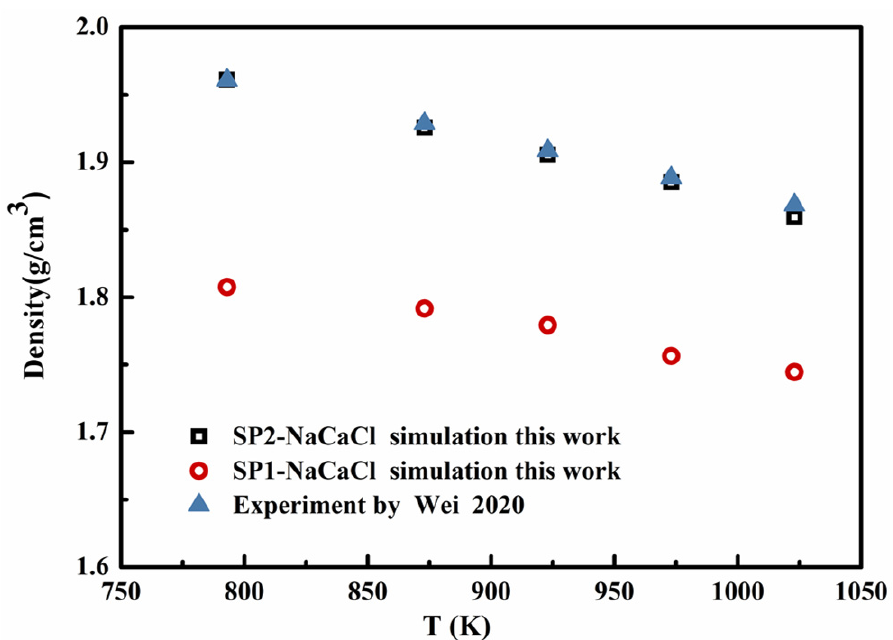
Figure 3. The density of binary eutectic salt NaCl ‐ CaCl 2 vs. temperature [4].